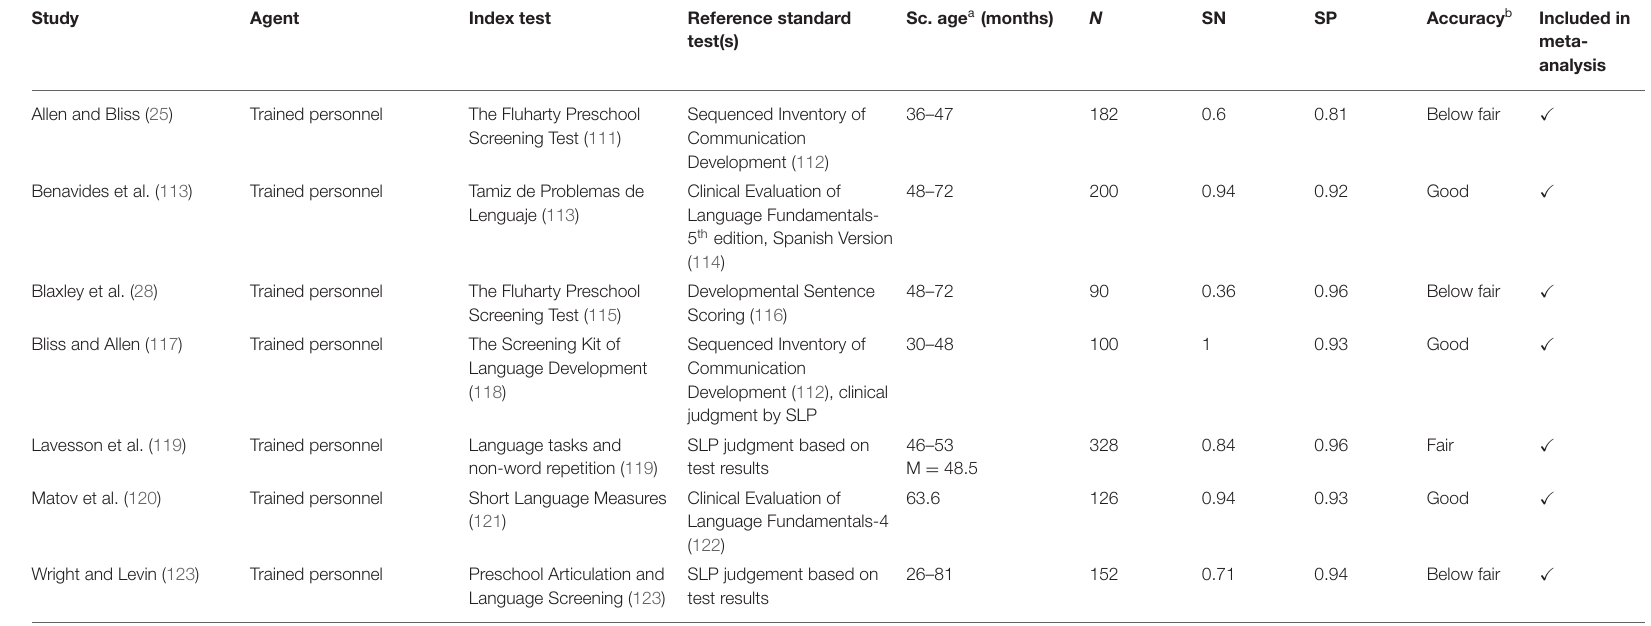
TABLE 3 | Studies involving tools based on both language ability and clinical